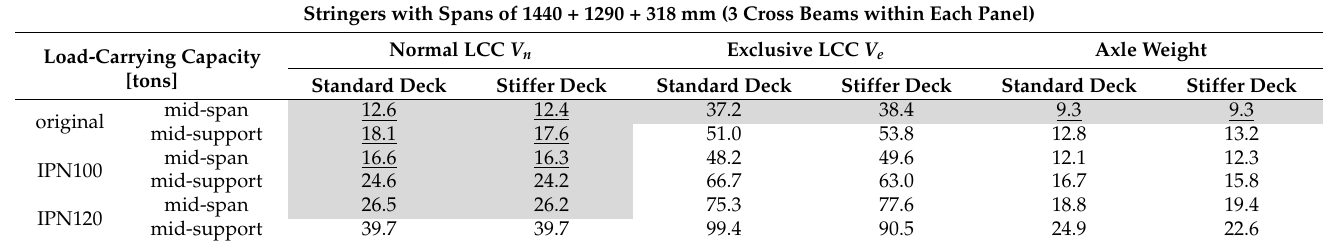
Table 6. Stringer load-carrying capacity for panels with 3 cross beams.